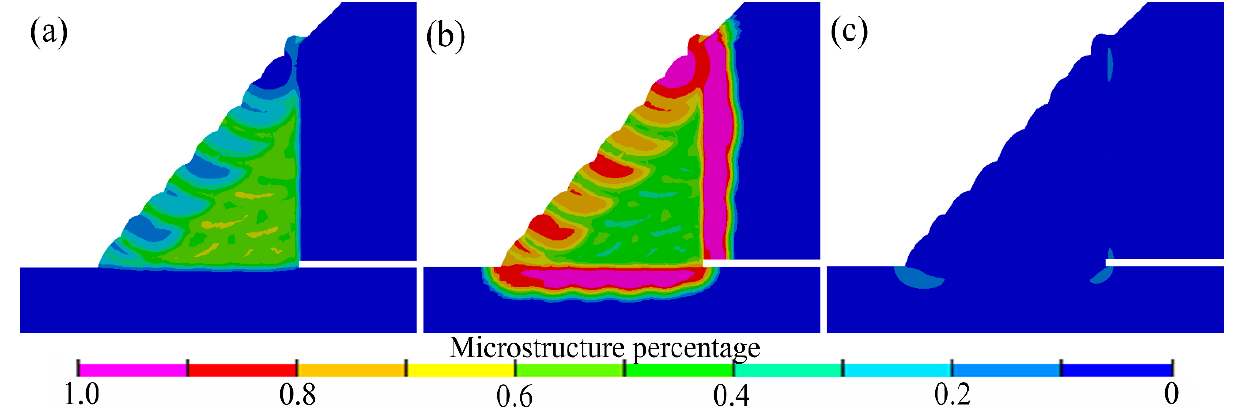
Figure 19. Microstructure predicted by SYSWELD: ( a ) ferrite, ( b ) bainite, ( c ) martensite.